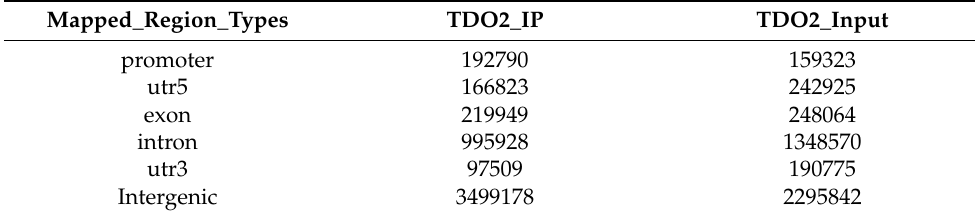
Table 2. Reads distribution across genomic